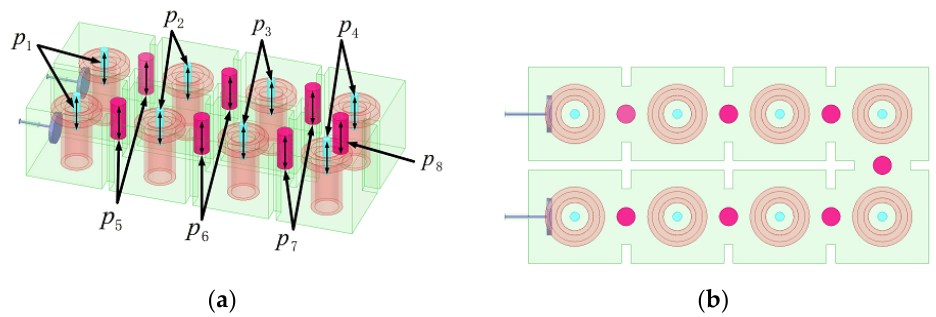
Figure 12. Eighth-order cavity filter. ( a ) Side view. ( b ) Top view.